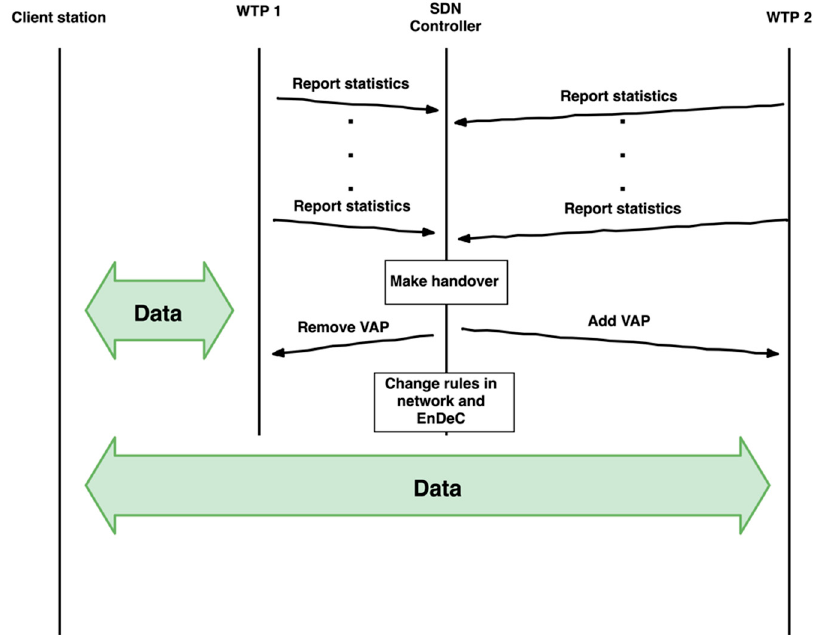
Figure 3. Handover process flow.